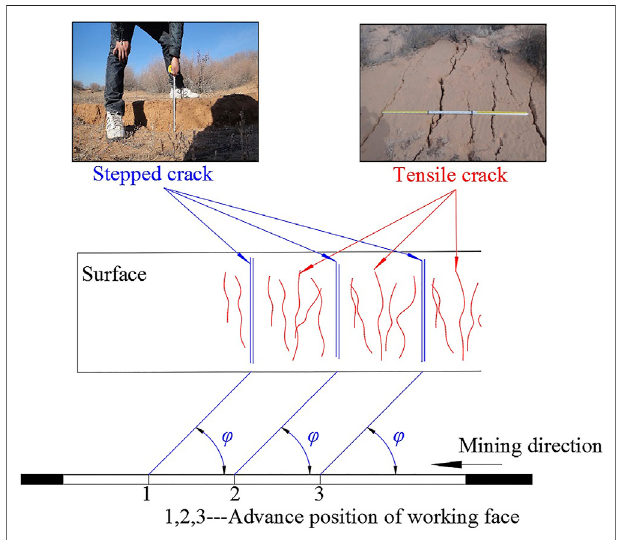
FIGURE 7 | Surface crack and its position